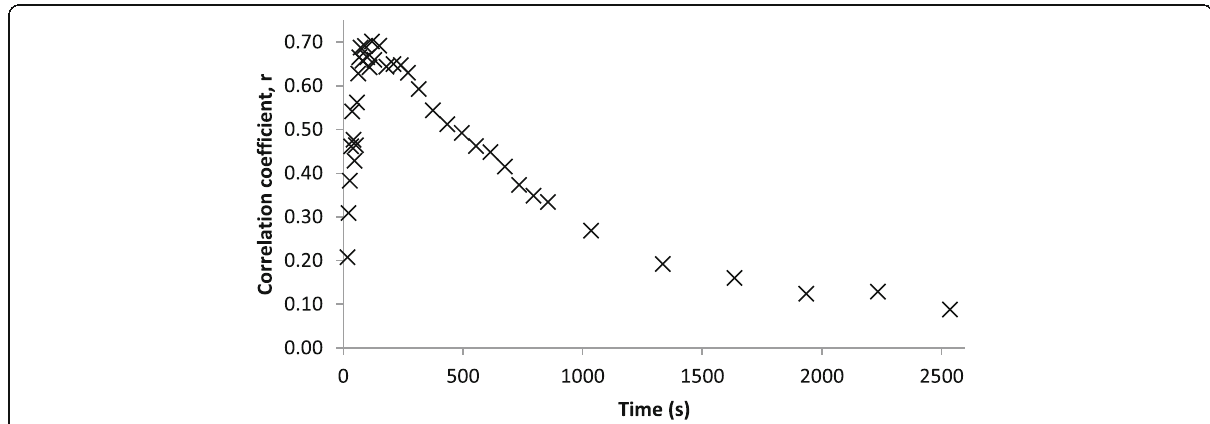
Fig. 7 Pearson r coefficients of correlation between BF values and FMISO uptake at a range of times